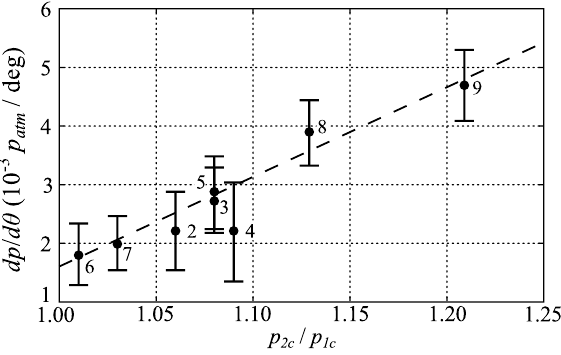
Figure 14. Pressure gradient on the center portion of the compressor blades (0.25 < θ / c < 0.75) as function of the measured pressure ratio over the compressor for cases 2–9. Same data as in Figures 11 and 12.